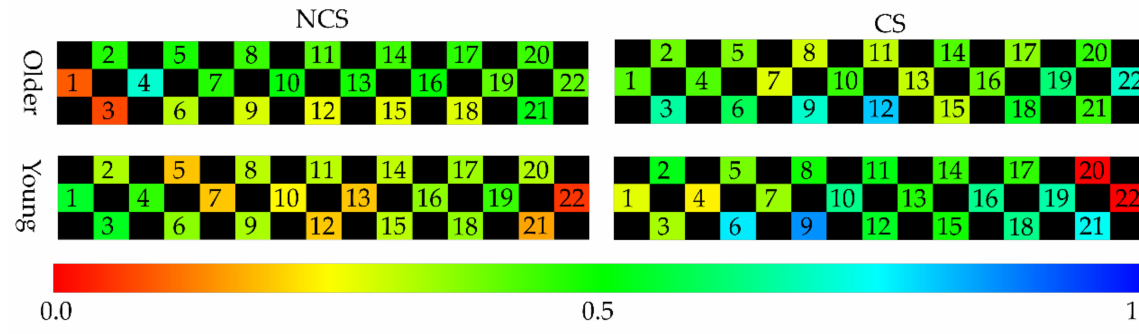
Figure 6. Heat map of brain activity when the driver feels calm.